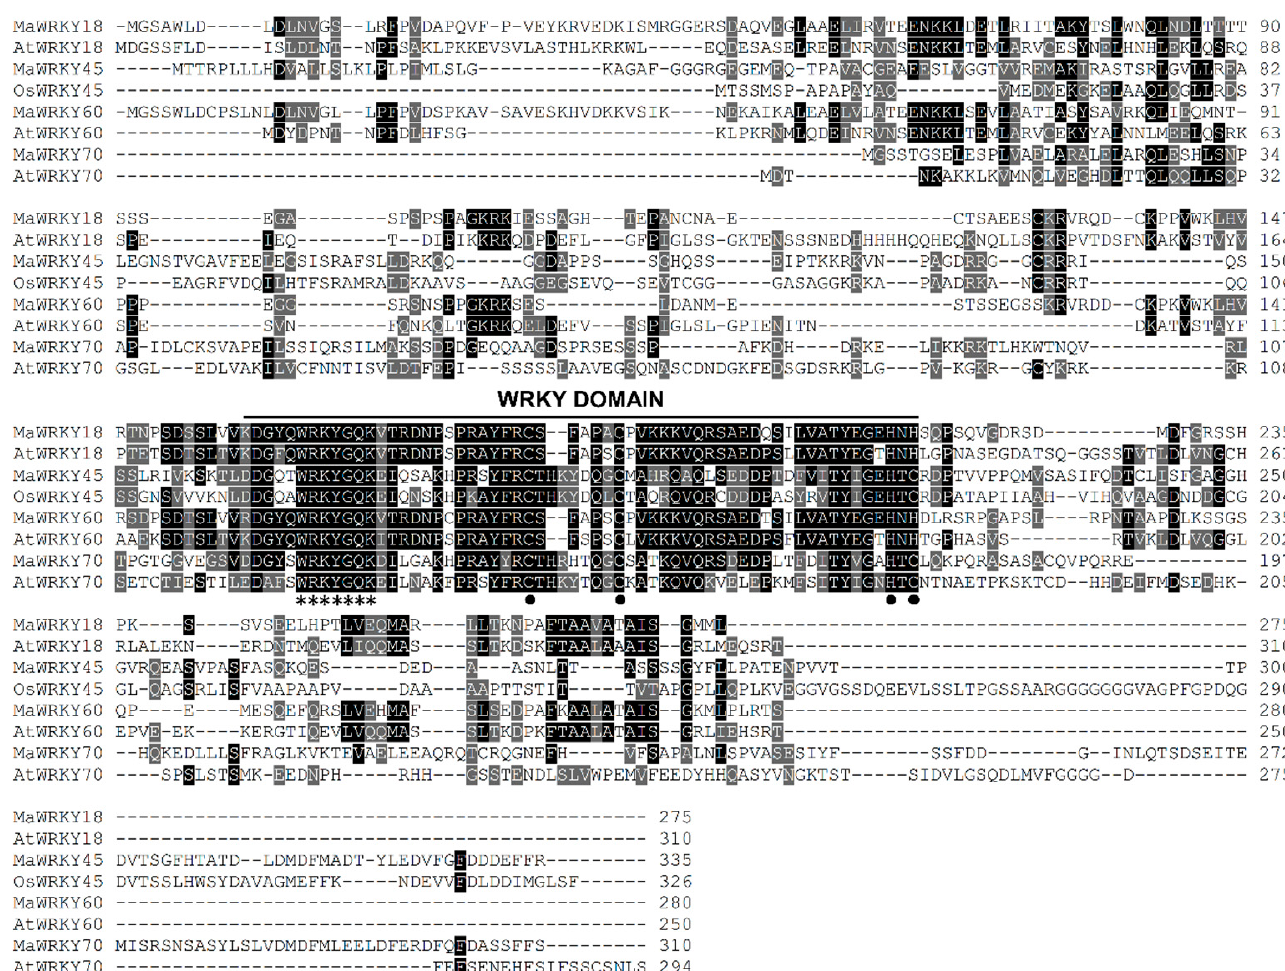
Figure 2. Multiple sequence alignment of the proteins MaWRKY18, MaWRKY45, MaWRKY60, MaWRKY70, and their homologs from rice and Arabidopsis . Identical and similar amino acids are shaded in black and gray, respectively. The amino acids of the WRKYGQK and zinc-finger motifs are highlighted with asterisks and black circles, respectively.